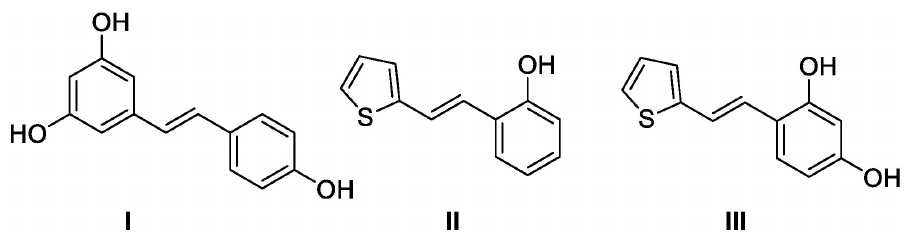
Figure 1. Resveratrol ( I ) and thienostilbenes ( II and III ) with improved antioxidant